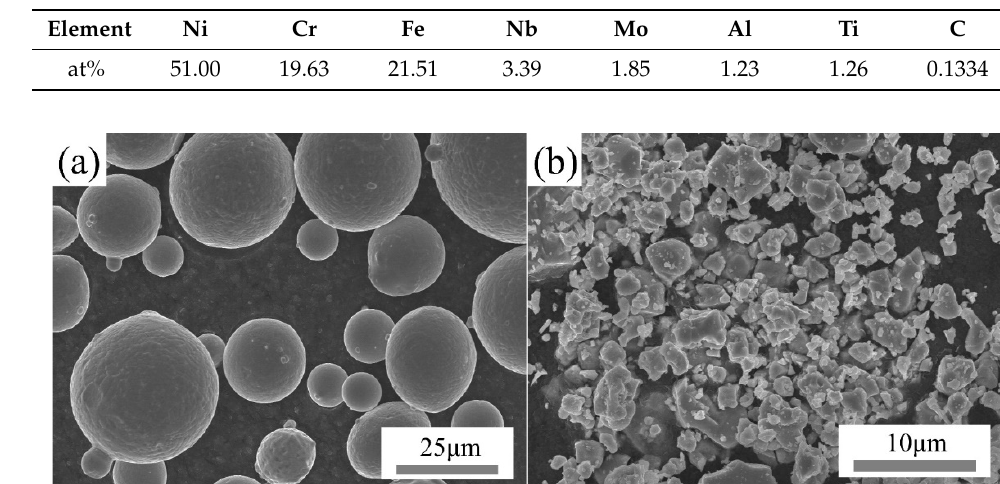
Figure 1. ( a ) gas atomized powder of Inconel 718, and ( b ) NbC flakes.